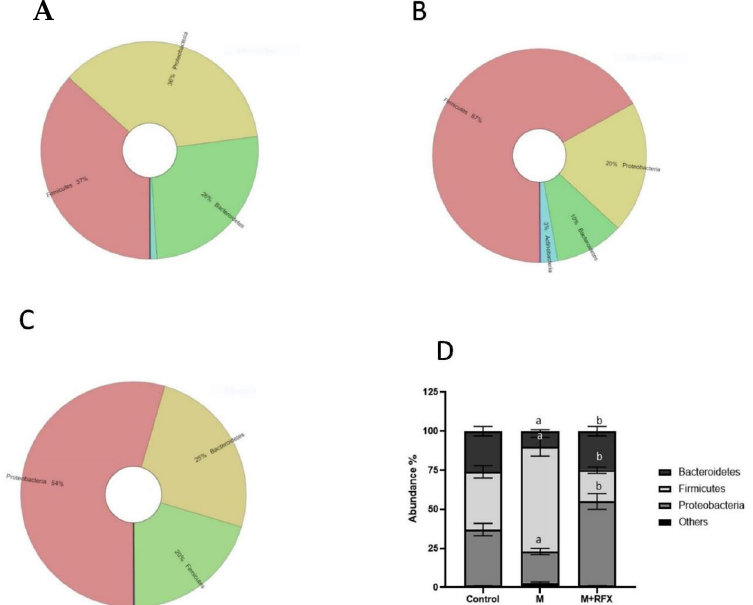
Figure 6. Effects of RFX treatment on the microbial diversity of the gut microbiota at the phylum level in rats exposed to malathion. Krona charts showing the phylum levels in the control group ( A ), malathion group ( B ), and malathion+rifaximin group ( C ). ( D ): Representative stacked column for the relative abundance of gut microbiota at the phylum level (Proteobacteria, Firmicutes, Bacteroidetes) in the three rat groups. Data are presented as the means ± SEM. a, significant ( p < 0.05) versus control; b, significant ( p < 0.05) versus the malathion group; data were analyzed with one-way ANOVA followed by Bonferroni-corrected post hoc tests. RFX, rifaximin; M, malathion; M + RFX, malathion and rifaximin. Molecules 2022 , 27 , x FOR PEER REVIEW The ratio of Firmicutes to Bacteroidetes (Firm/Bac ratio) was significantly increased upon malathion exposure ( p < 0.05), which was mitigated by RFX treatment. Furthermore, krona classification charts and corresponding stacked bar charts showed the major composition and the relative abundance of gut microbiota at the class, order, and genus levels in rats’ intestinal content. After malathion exposure the main SCFA producing phylum, Bacteroidetes was down-represented (Figure 6B) as well as the key SCFA producer genus, Prevotella (Figure 7).